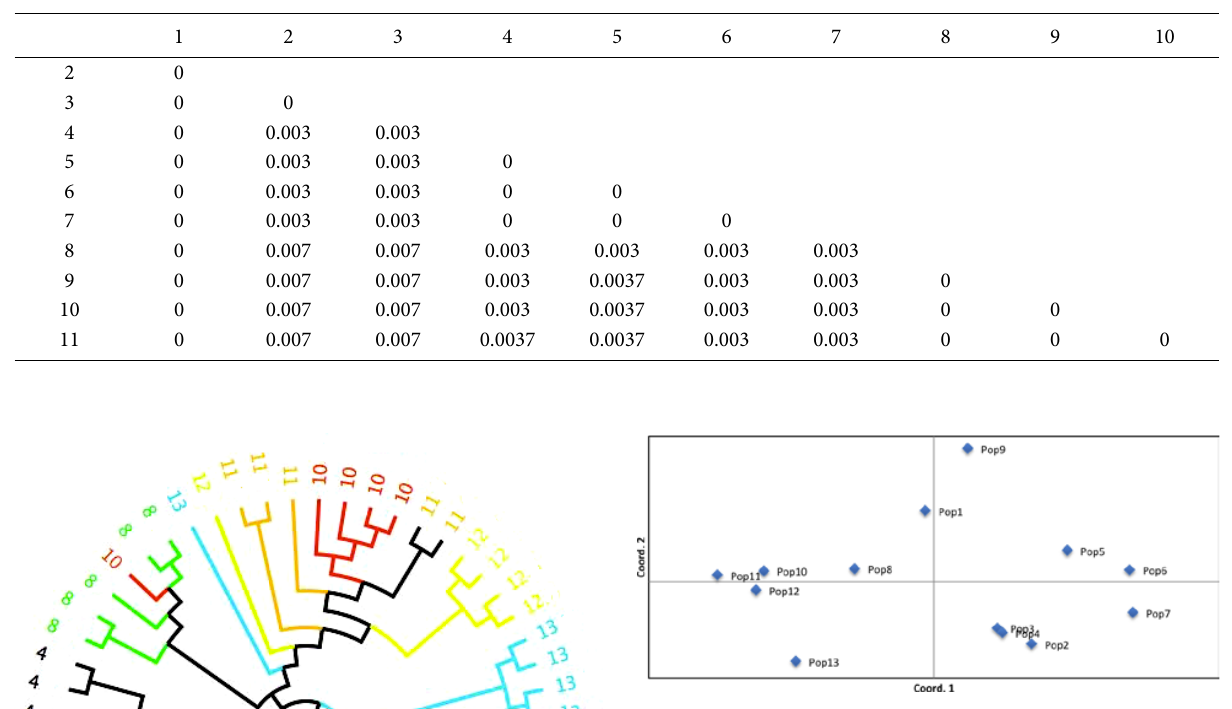
Table 9. Genetic distance among jujube cultivars based on nuclear DNA (ITS sequences) (populations numbers are according to Table 2).